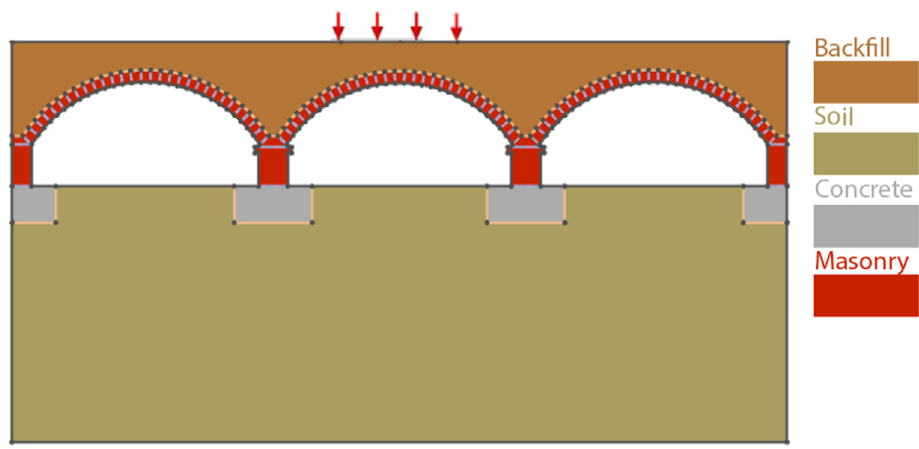
Figure 3. 2D limit state model in LimitState:GEO [30,35].